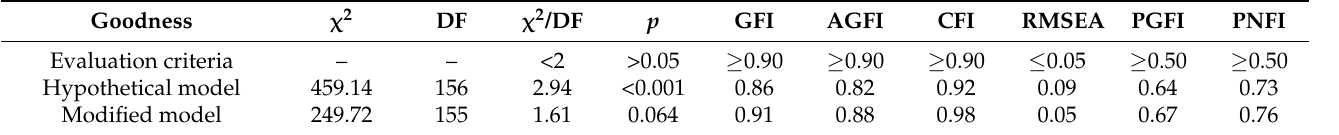
Table 3. Model fitness index for hypothetical and modified model (N =